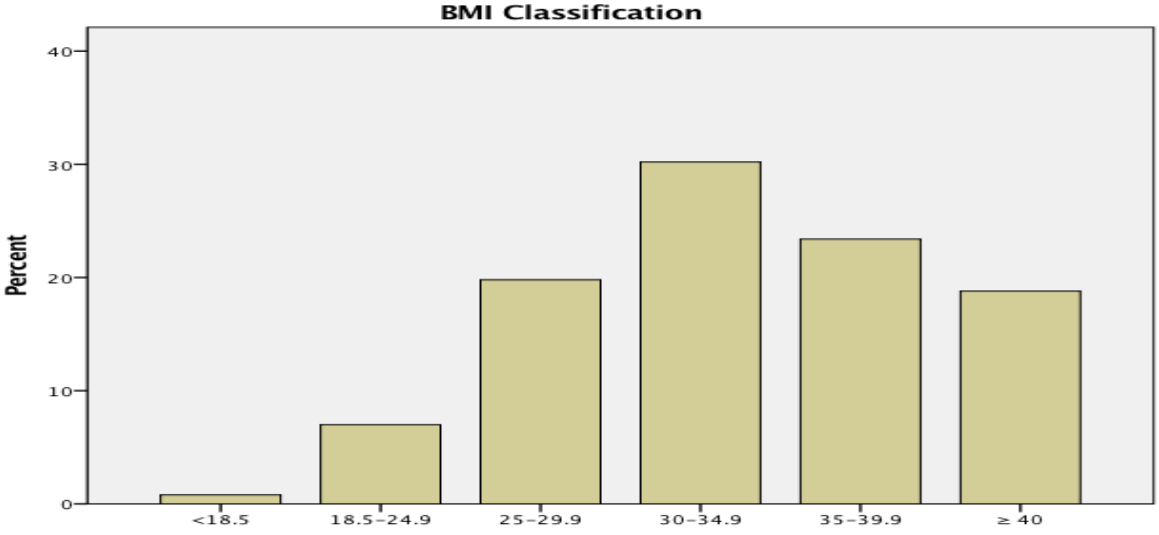
Figure 1. BMI (body mass index) of respondents: Underweight (<18.5 kg/m 2 )—1%; Normal (18.5–24.9 kg/m 2 )—7%; Overweight (25–29.9 kg/m 2 )—20%; Obese Class I (30–34.9 kg/m 2 )—30%; Obese Class II (35–39.9 kg/m 2 )—23%; Obese Class III ( ≥ 40 kg/m 2 )—19%.